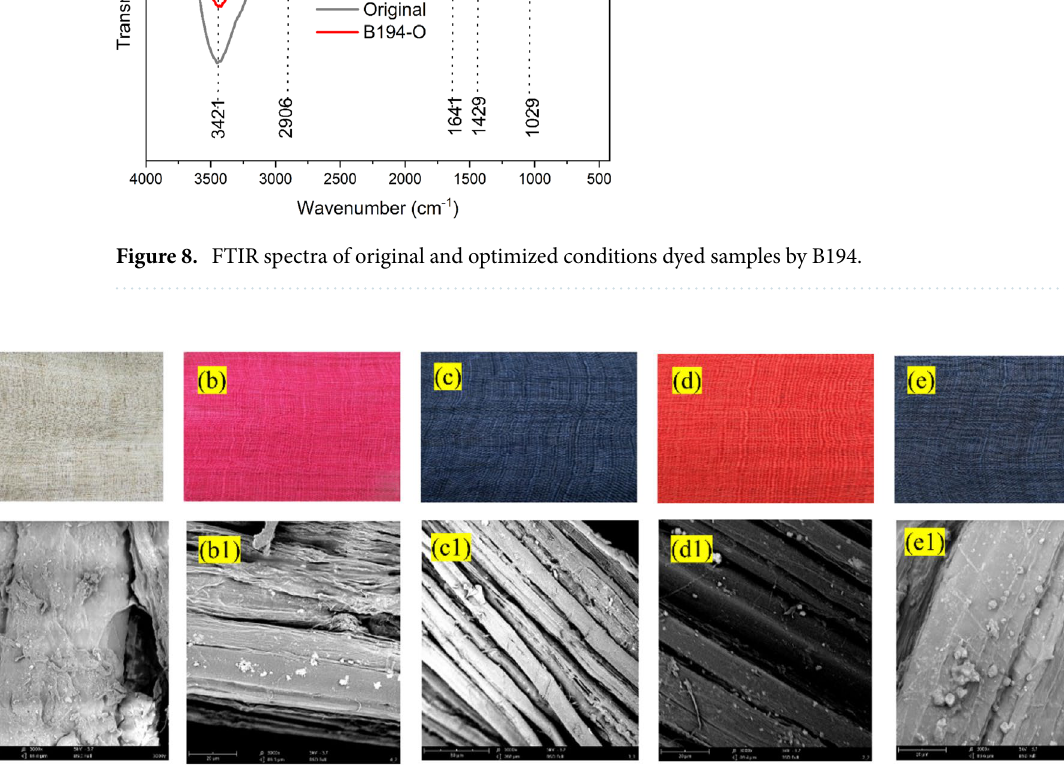
Figure 9. Pictures of ( a,a1 ) original and ( b,b1 ) R2, ( c,c1 ) B194, ( d,d1 ) O5, ( e,e1 ) B194-O dyed traditional grass cloth and with their SEM images, respectively.